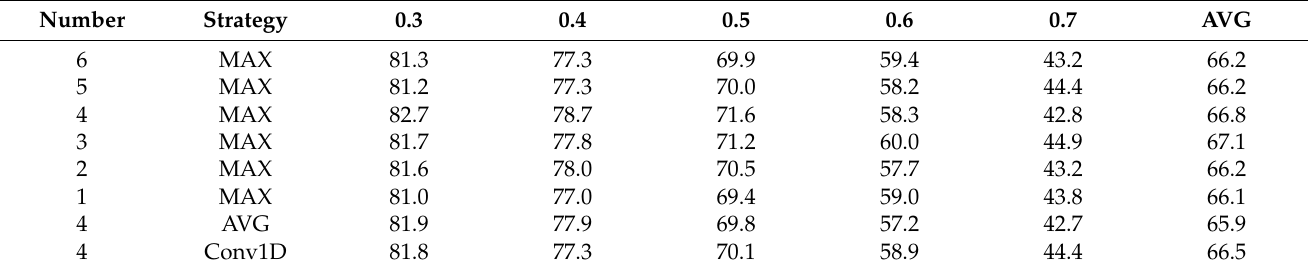
Table 3. Ablation Study (impact of MTC module). Comparing the effects of different branch numbers and fusion strategies between branches on THUMOS-14, measured by mAP@tIoU at different thresholds and the average mAP (mAP@avg)